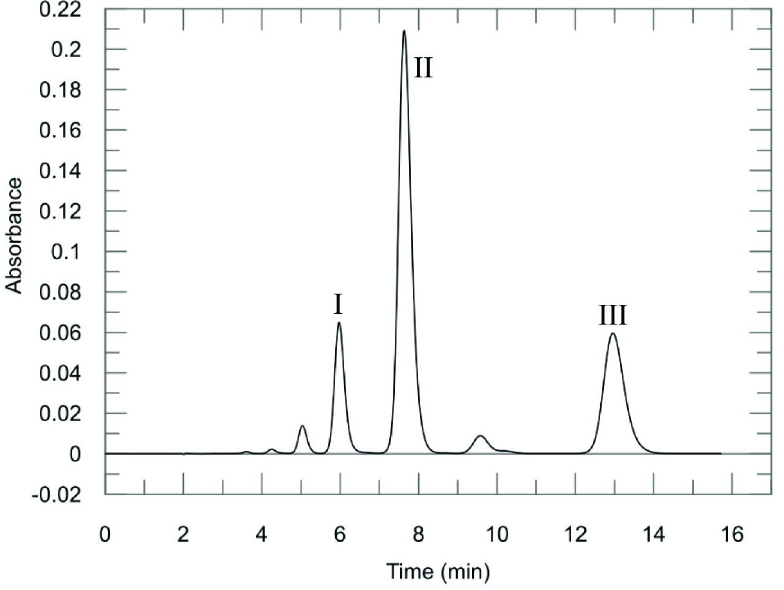
Fig 1. Chromatogram showing the separated peaks of the commercial Safranine O mixture. The mixture was separated on a Higgins Proto 300 4.6x250 mm column. The chromatographic method is isocratic and consists of 27% acetonitrile/73% water with 0.1% trifluoroacetic acid at a flowrate of 2 mL/min. The chromatographic trace was made by plotting the absorption at 520 nm vs. time. The peaks are numbered in order of elution and correspond to the scheme in Table 1.